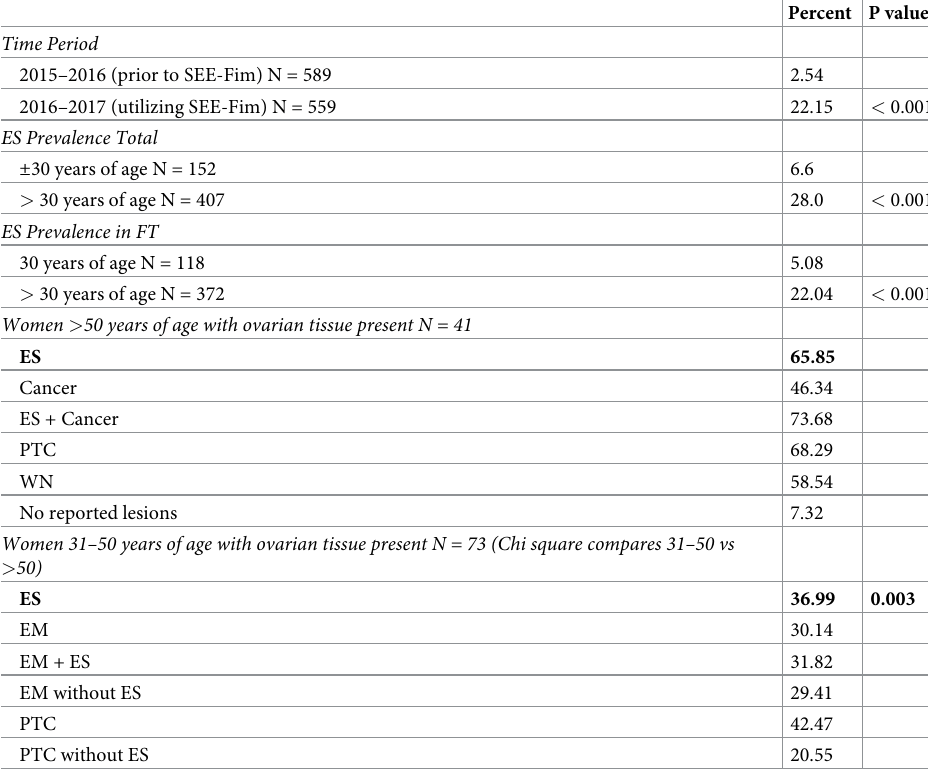
Table 1. Endosalpingiosis prevalence (Chi square statistic).